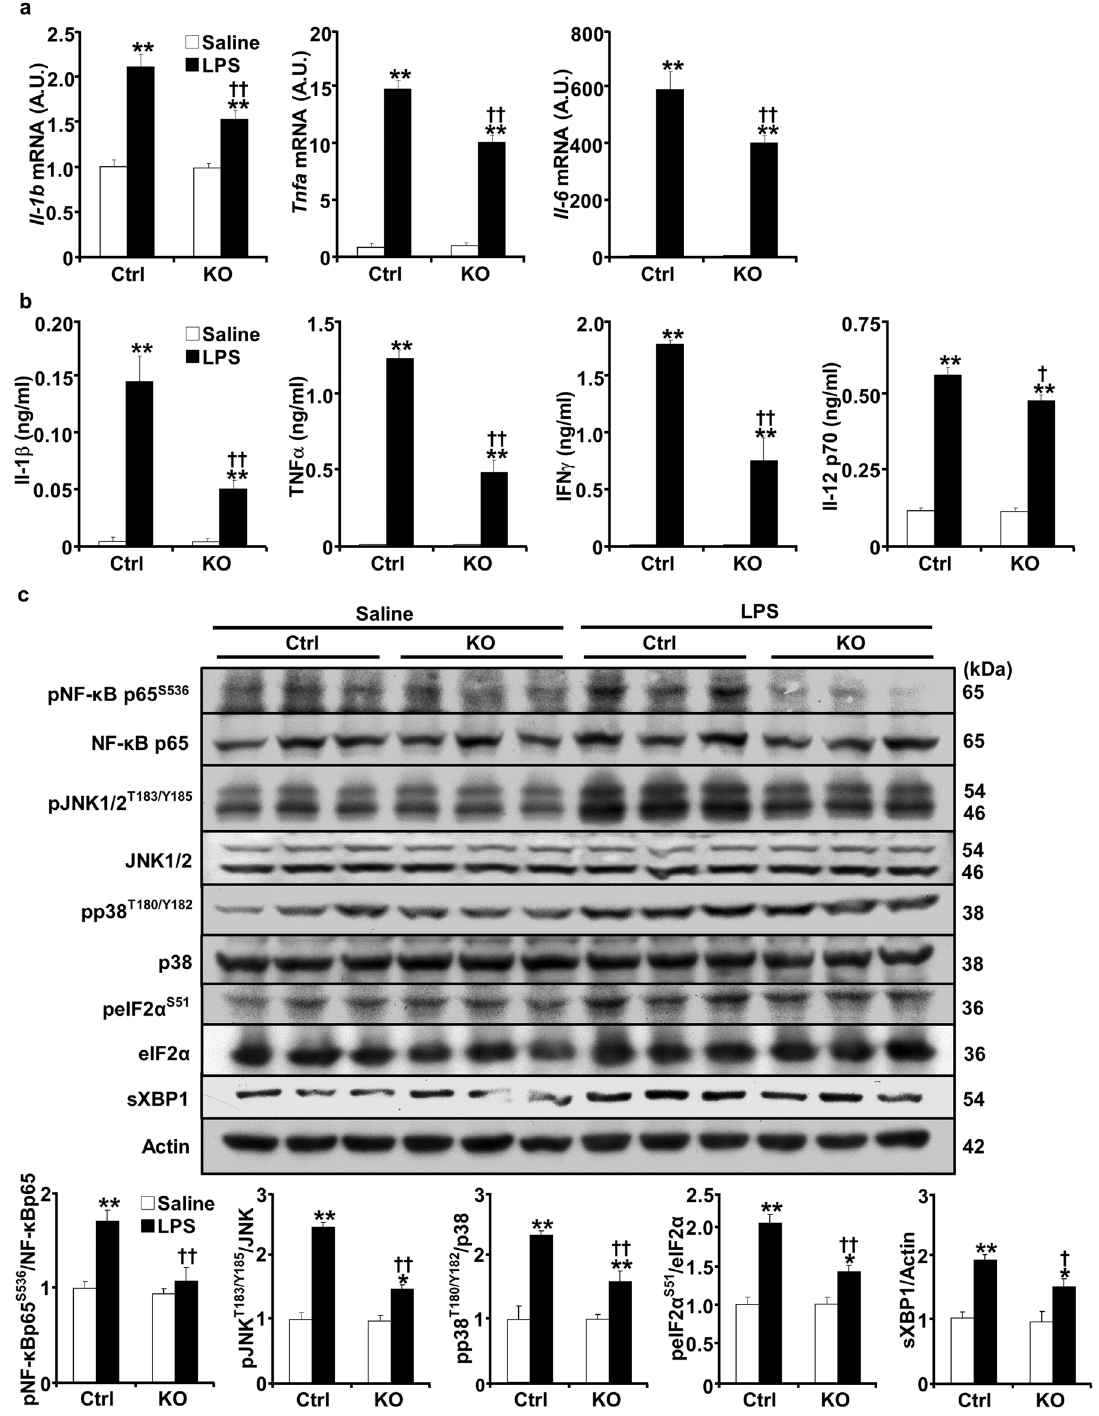
Figure 4. Attenuated LPS-induced inflammatory response in pod-Shp2 KO mice. Renal mRNA of Il - 1b , Il - 6 and Tnfa ( a ), and plasma concentrations of IL-1 β , TNF α , INF γ and IL-12 p70 ( b ) in saline and LPS-treated control (Ctrl, n = 6) and pod-Shp2 knockout (KO, n = 6) mice. ( c ) Kidney lysates from Ctrl and KO mice without (saline) and with LPS treatment were immunoblotted for phosphorylated NF- κ B p65, JNK, p38, peIF2 α and their respective proteins, spliced XBP1 (sXBP1), and actin as a loading control. Representative images are shown. Bar charts represent pNF- κ B p65/NF- κ B p65, pJNK/JNK, pp38/p38, peIF2 α /eIF2 α and sXBP1/actin as means + SEM. For all bar charts, * p < 0.05 and ** p < 0.01 indicate a significant difference between saline and LPS treatments; † p < 0.05 and †† p < 0.01 indicate a significant difference between Ctrl and KO mice. A.U., arbitrary